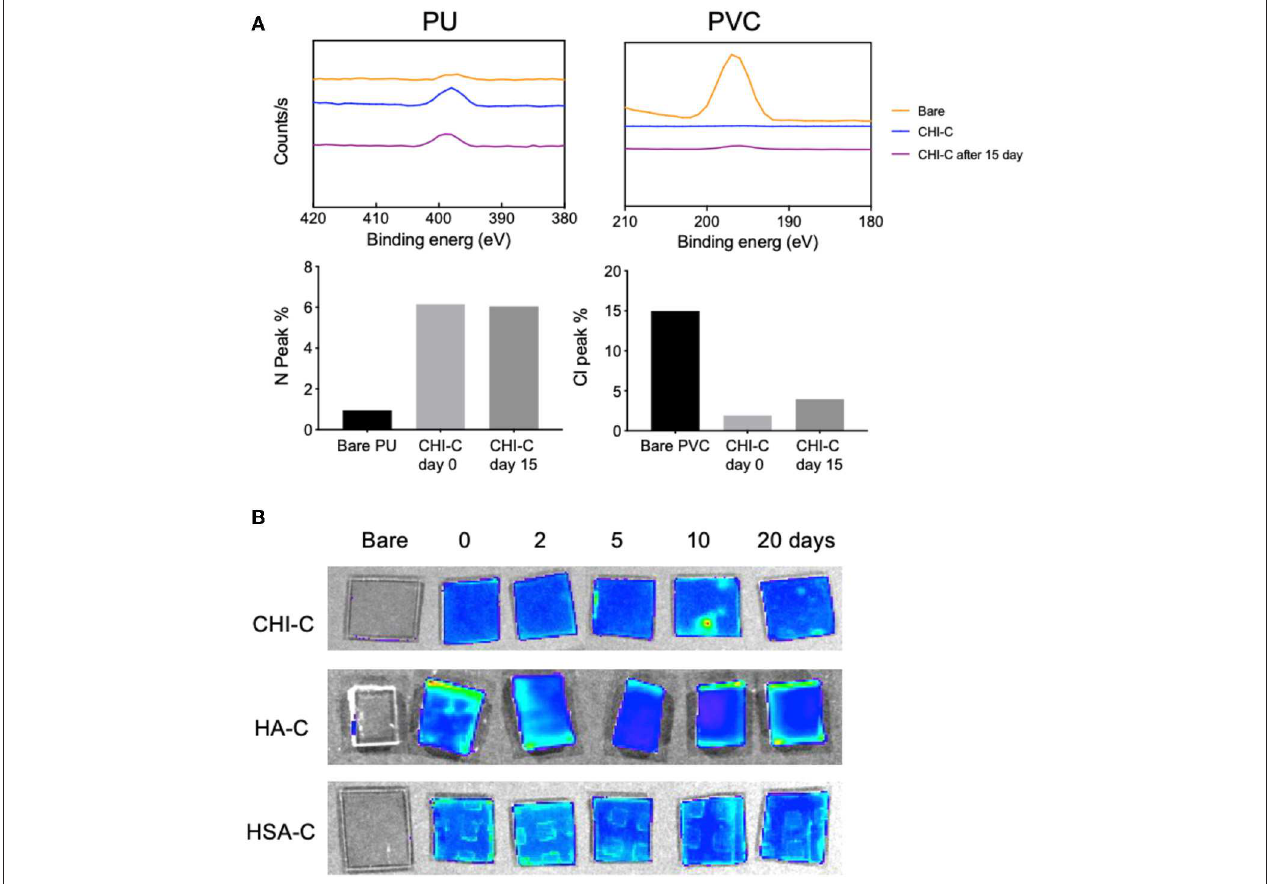
FIGURE 5 | Assessment of stability of the catechol-functionalized hydrogel coatings with 6 deposition cycles on materials used in urethral catheters. (A) XPS peaks of PU and PVC substrates with unmodified surfaces or with CHI-C and quantifications of surface atomic compositions [nitrogen (N 1s) and chloride (Cl 2p)]. (B) Fluorescent images of FITC modified CHI-C, HA-C, and HSA-C coatings on PU substrates after immersion in PBS for 20 days.